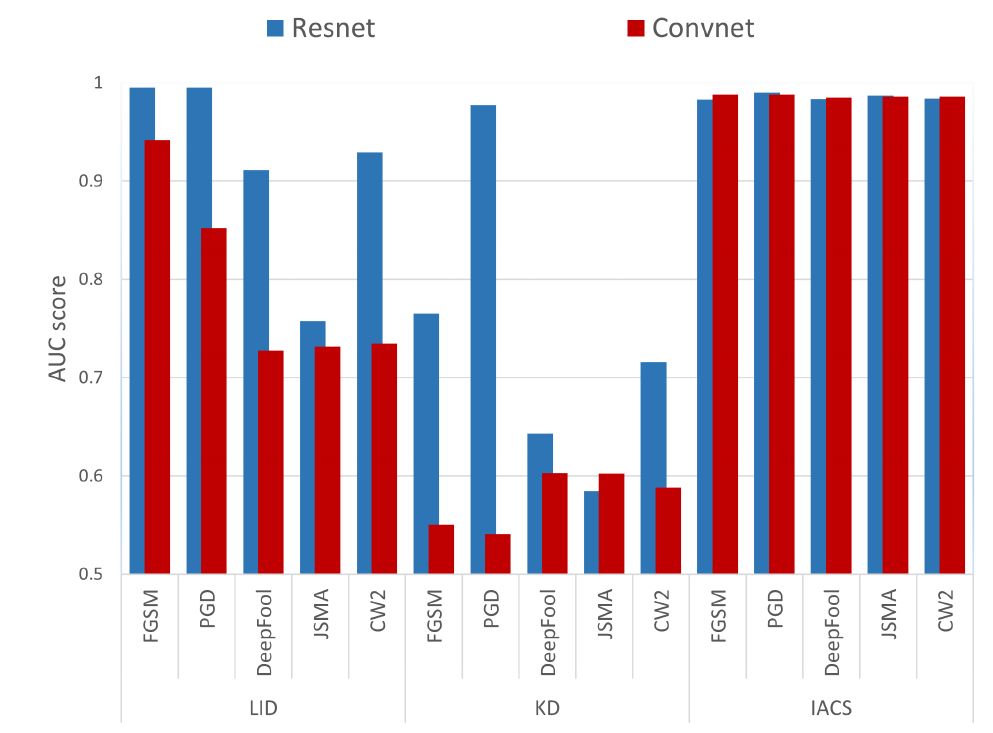
Figure 6. Crossing model performance: the green bars denote the AUC scores of the detector which extracts disentangled features from Resnet (target model), and the red bars denote the AUC scores of the detector based on